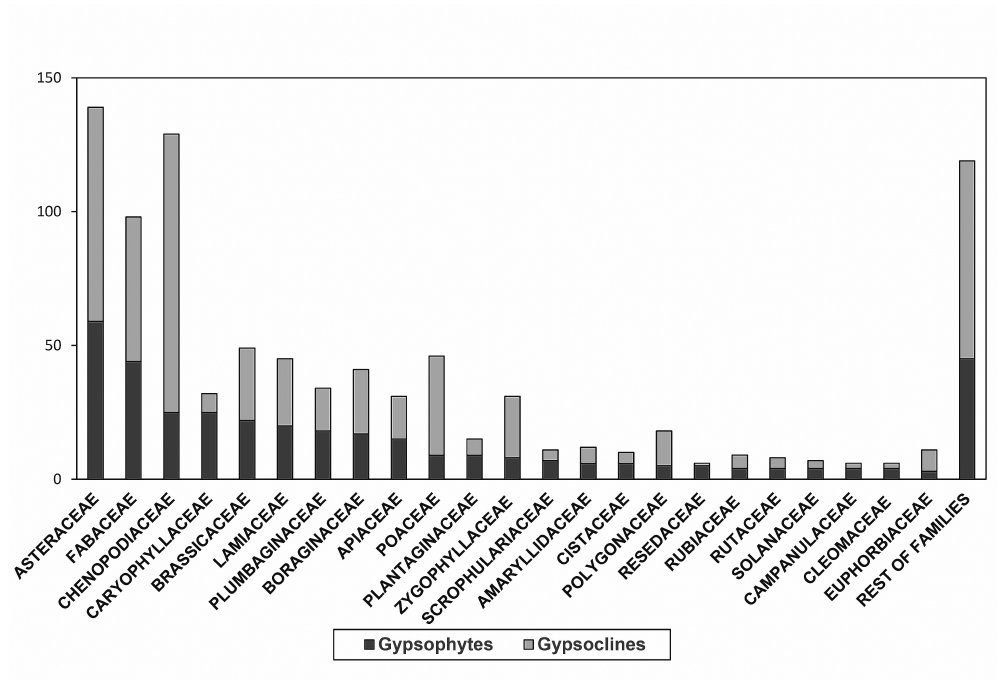
Figure 3. Distribution of taxa by